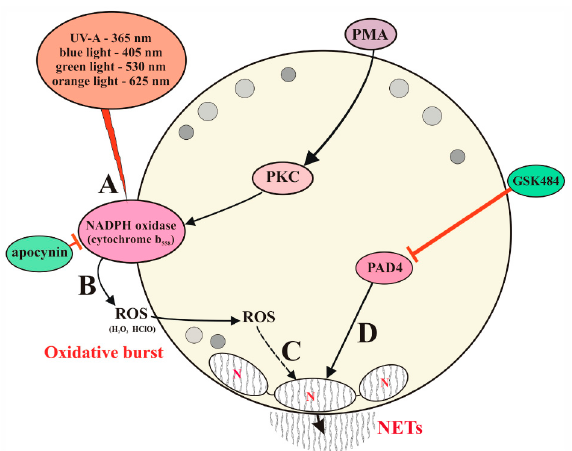
Figure 6. The proposed mechanism of NETosis induced by UV-A and wavelengths of visible light. ( A ) Cytochrome_ b 558 , being the catalytic electron transport part of NADPH oxidase, absorbs UV-A, blue, green, and orange light, which leads to the activation of NADPH oxidase and the following ROS generation ( B ). ROS activate the translocation of enzymes NE and MPO from the azurosomes of azuphilic granules to the cytoplasm and their subsequent migration to the nucleus ( C ), where— together with PAD4 ( D )—they promote the decondensation of nuclear chromatin and NETosis. Inhibition of NADPH oxidase by apocynin and PAD4 by GSK484 leads to suppression of NETosis. Neubert et al. [9] observed NET formation after the irradiation of neutrophils starting from 18 J/cm 2 at 375 nm wavelength. This dose corresponds to approximately 40 h